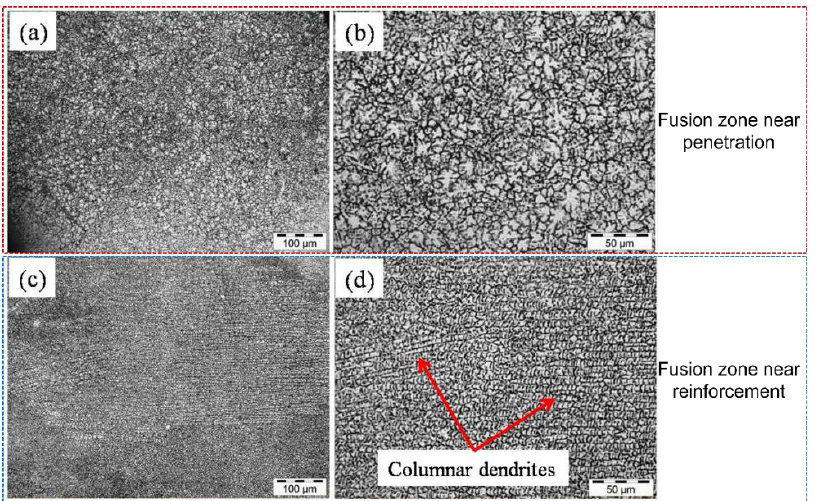
Figure 8. Optical microstructures of ( a , b ) FZ near penetration at low and high magnifications respectively; ( c , d ) FZ near reinforcement at low and high magnifications, respectively.